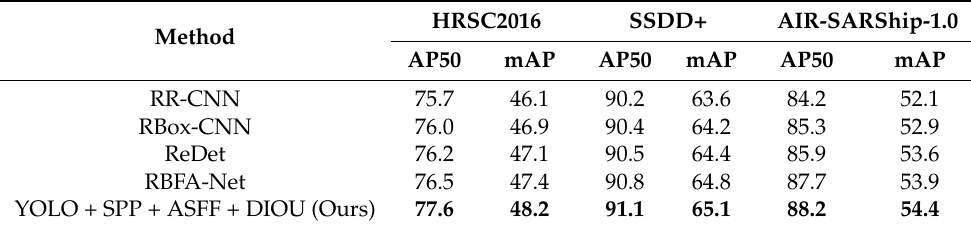
Table 3. Results for other